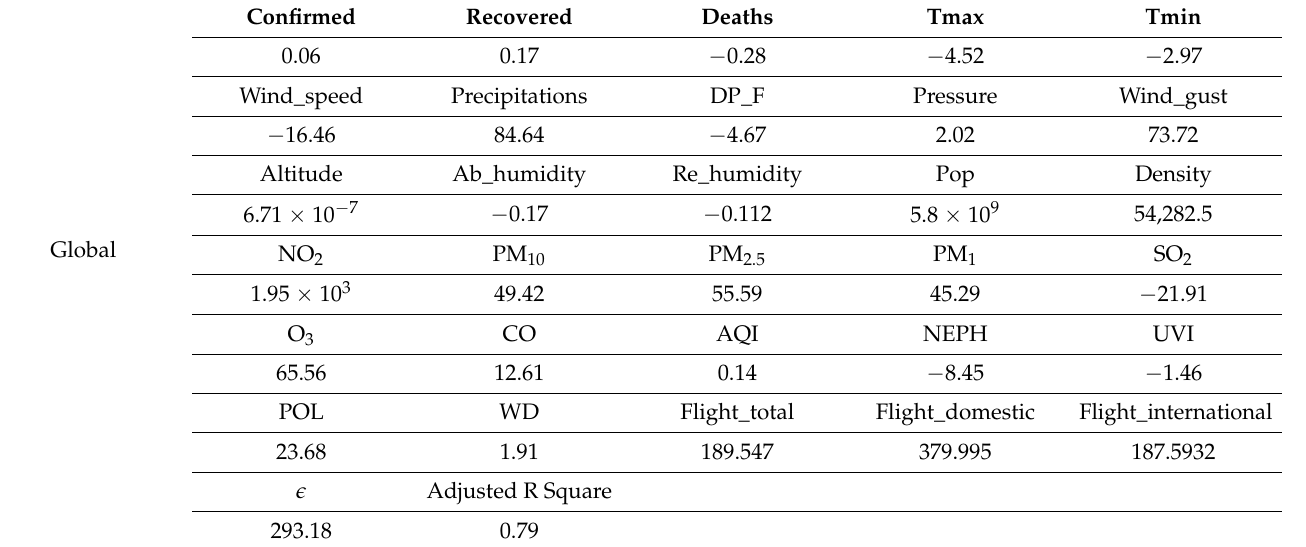
Table 4. Regression equation